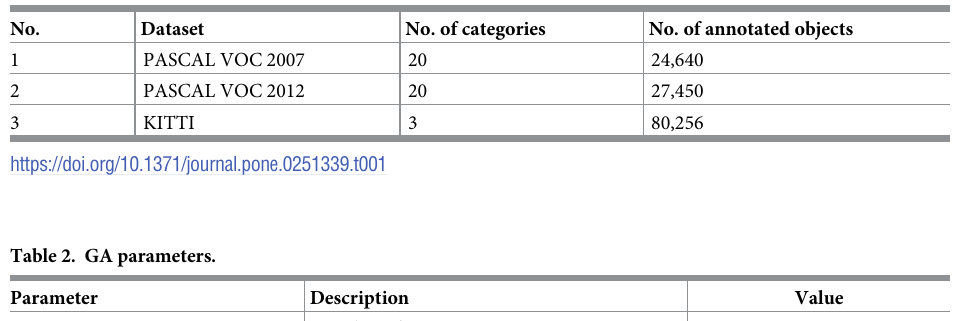
Table 1. Dataset information.